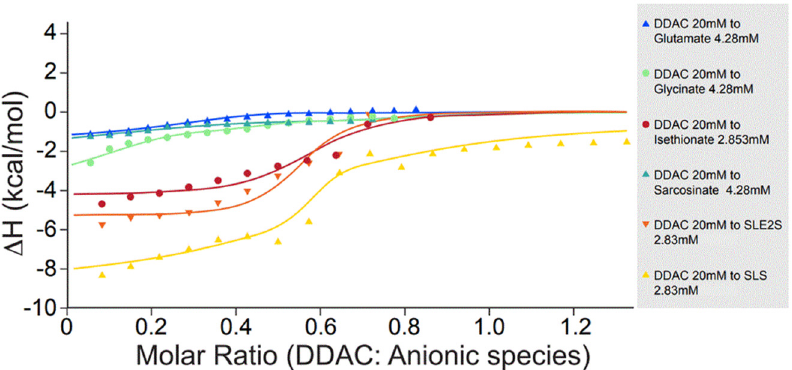
Figure 4. Enthalpy variation per injection vs. DDAC/anionic surfactant molar ratio. DDAC was in- jected into the reaction cell containing different aqueous anionic solutions at 25 °C .